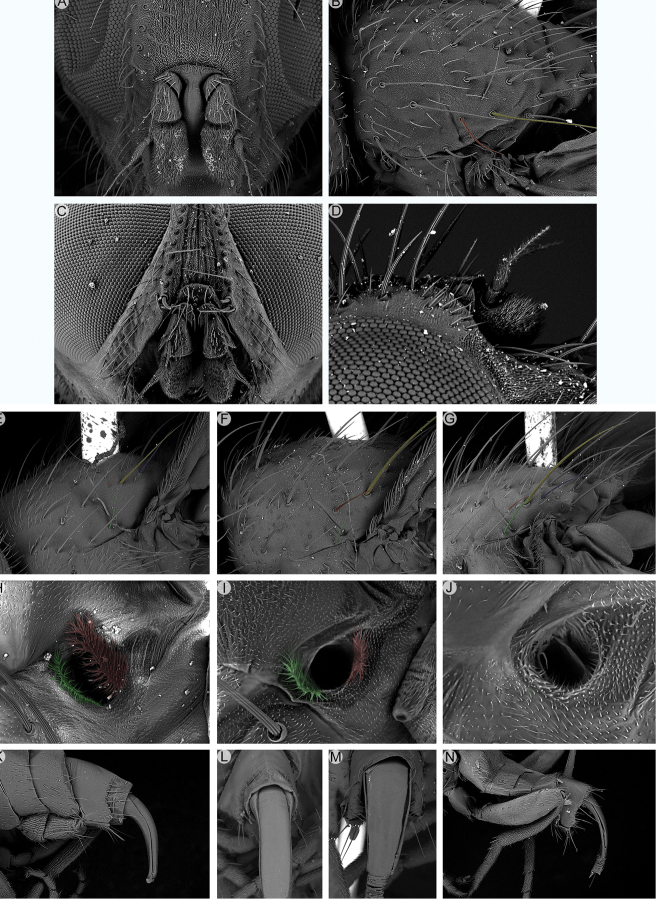
SEM images of diagnostic characters. A, BPolleniidaeAMorinia
carinata ♂ (South Africa) [paratype], detail of head in anterodorsal view BMorinia
carinata ♂ (South Africa) [paratype], thorax in dorsolateral view [colour coding as E–G] C–NRhinophoridaeCPhyto
adolescens ♂ (Italy), detail of head in anterodorsal view DMelanophora
chia ♂ (Italy), detail of anterior part of head in lateral view E–G thorax in dorsolateral view [B, E–G colour coding: red = first postsutural supra-alar seta; yellow = second postsutural supra-alar seta; blue = third postsutural supra-alar seta; green = posterior notopleural seta] EParazamimus
congolensis ♀ (Burundi) FQueximyia
flavipes ♂ (South Africa) GRhinomorinia
sarcophagina ♂ (Italy) H–J metathoracic spiracle [colour coding: green = anterior lappet; red = posterior lappet] HBaniassa
fascipennis ♀ (Israel) IRhinomorinia sp. ♀ (South Africa) JMelanophora
basilewskyi ♀ (Kenya) K–NAxinia spp. (Australia), female oviscapt K, LAxinia
zentae in lateral view (K) and posterior view (L) M, NAxinia sp. in lateral view (M) and posterior view (N).